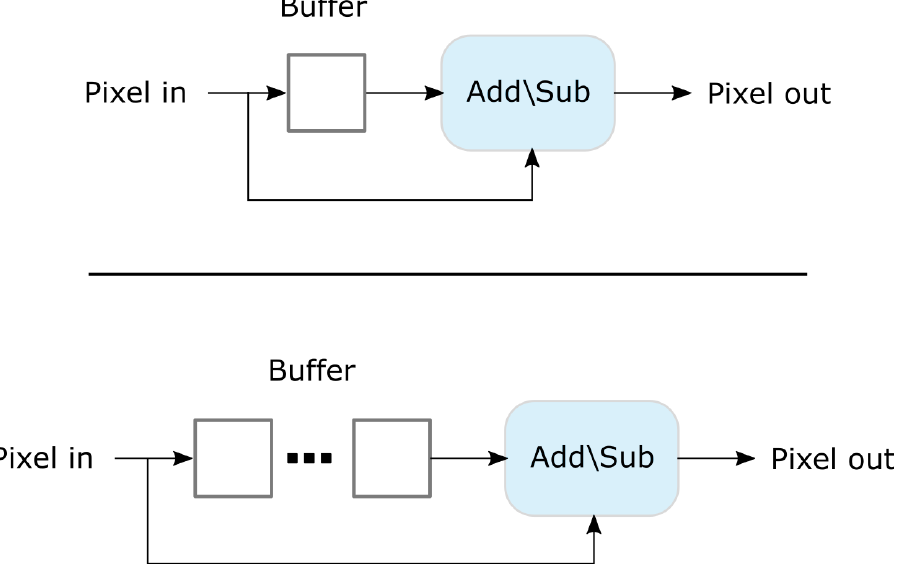
Figure 5. Line buffers and arithmetic operations used to form jet feature building blocks. A single pixel buffer (top) is used to compute jet building block operations in the x direction and a line buffer (bottom) is used to compute operations in the y direction. Addition is used for scaling factors and subtraction is used for partial